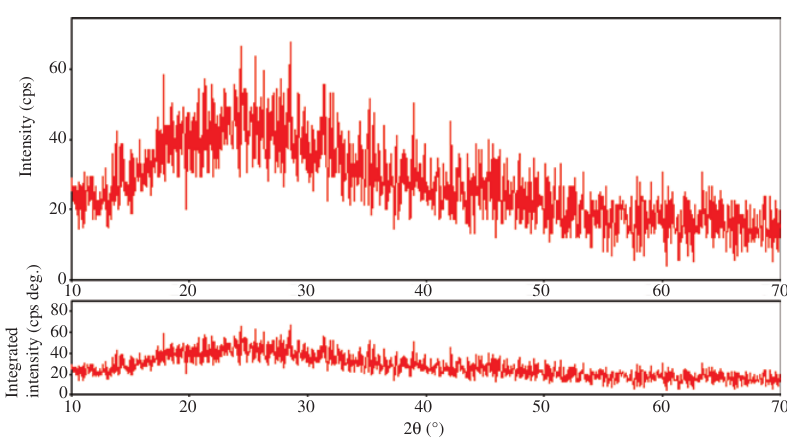
Figure 21: XRD analysis of GFRP composites with 5% CNTs.